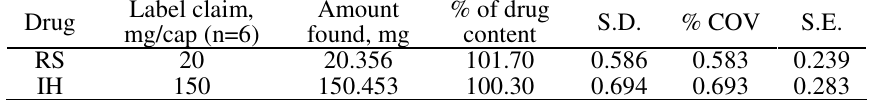
Table 1. Studies of rabeprazole sodium and itopride hydrochloride in marketed formulation. Drug